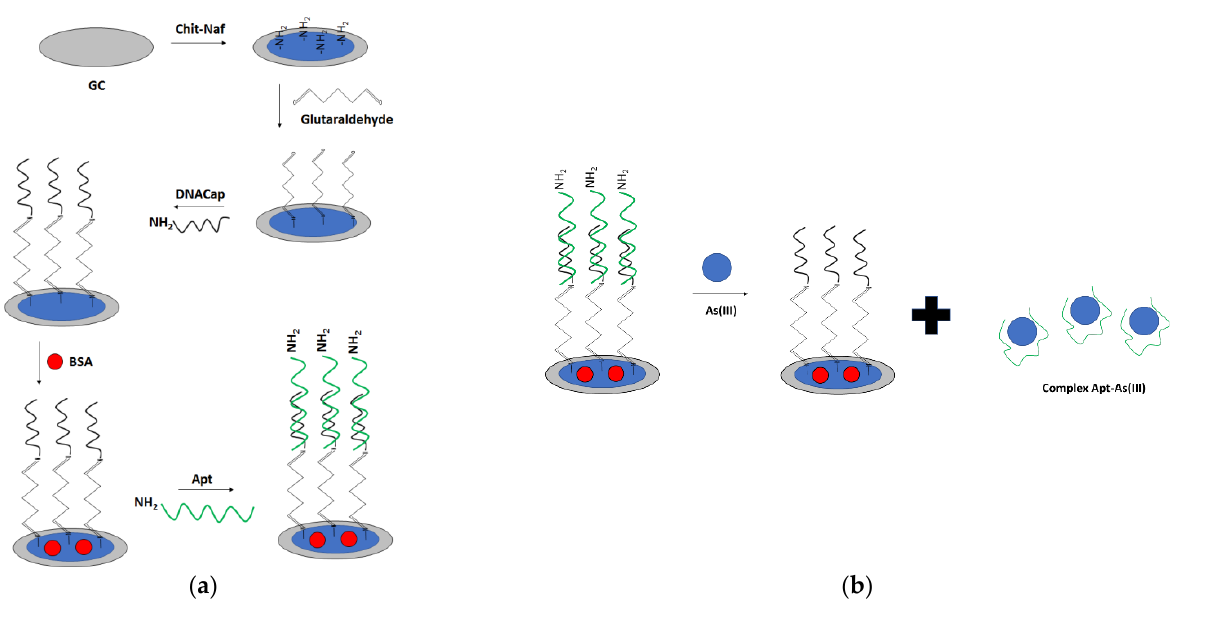
Figure 29. The sensing principle scheme of a dual optical and electrochemical sensor towards arsenic ion. ( a ) sensing layer preparation; ( b ) arsenic ion detection.